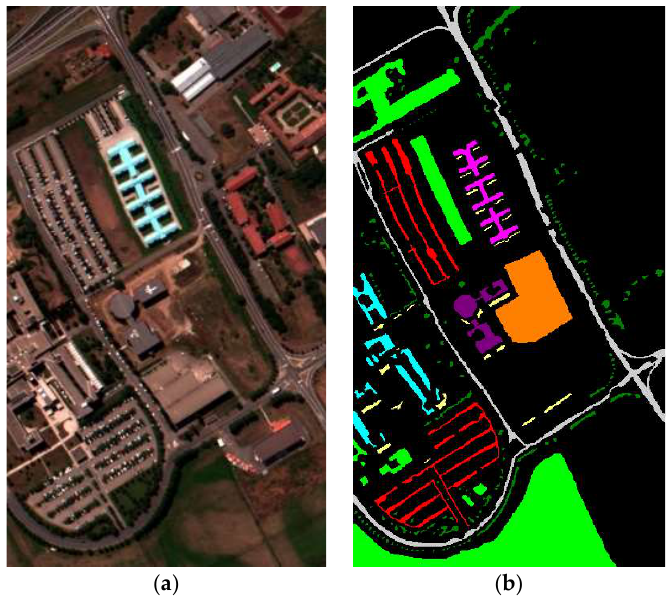
Figure 4. ( a ) false color map and ( b ) ground truth of the University of Pavia dataset.